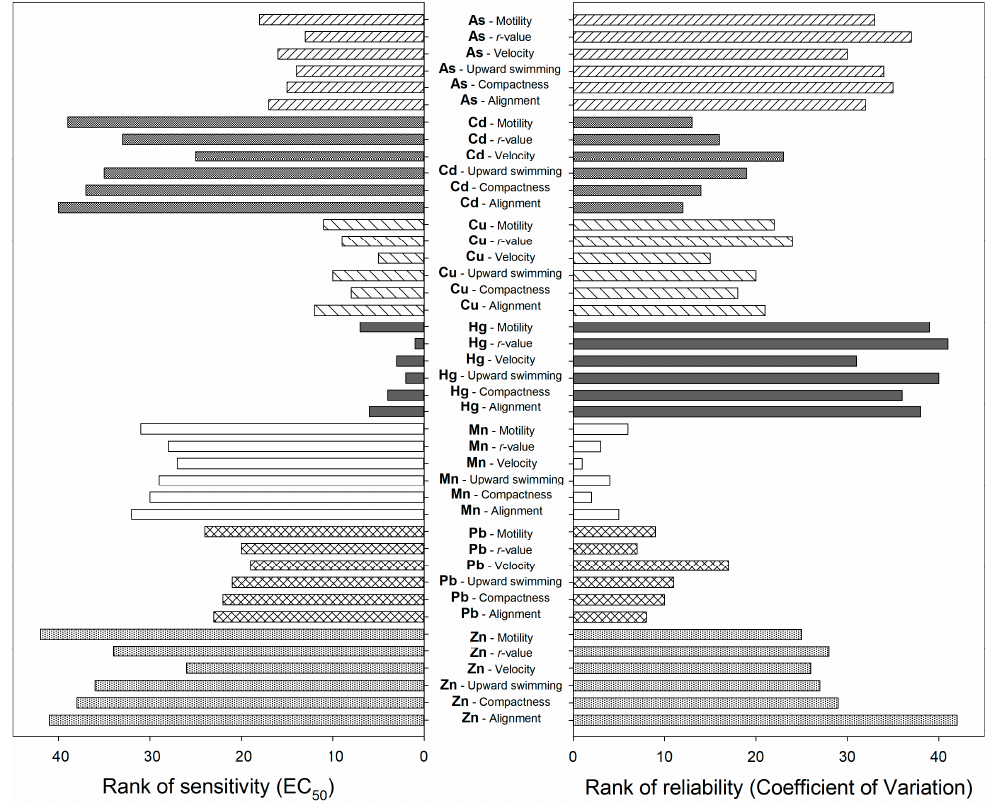
Figure 2. Mean ranks of sensitivity and reliability for each of the six end points (motility, r -value, velocity, upward swimming, compactness, and orientation) in Euglena agilis tests with seven metals (As, Cd, Cu, Hg, Mn, Pb, and Zn).